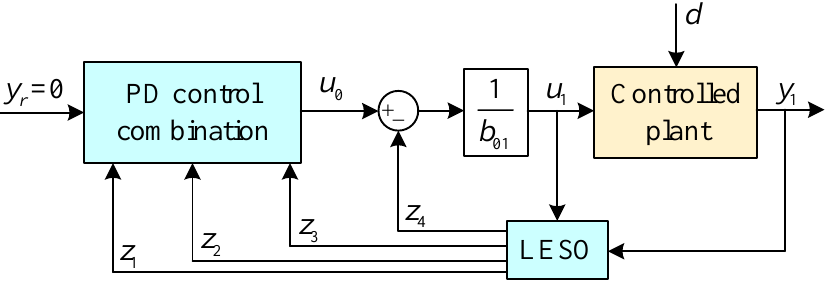
Figure 2. Structure diagram of